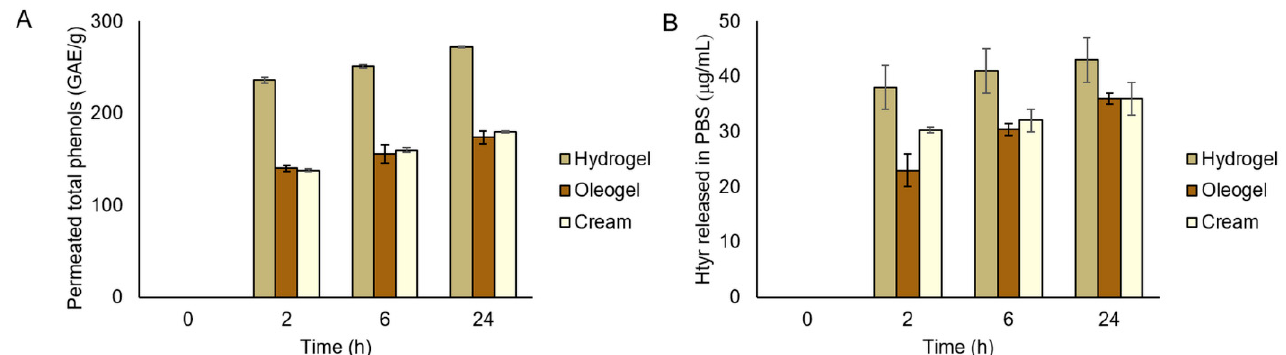
Figure 7. ( A ) Total phenols permeated from OFE ‐ loaded hydrogel, oleogel, and cream across